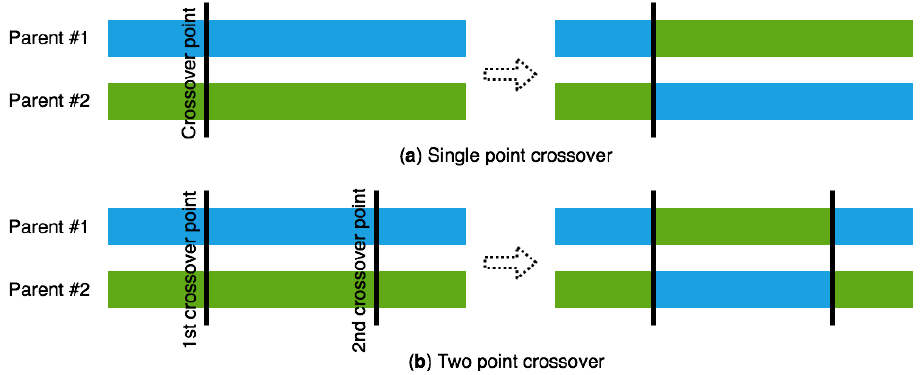
Figure 4. Genetic operator crossover between alleles. ( a ) Single point crossover in which one crossover point is selected, binary string from beginning of chromosome to the crossover point is copied from one parent, the rest is copied from the second parent. ( b ) Two-point crossover in which two crossover point are selected, binary string from beginning of chromosome to the first crossover point is copied from one parent, the part from the first to the second crossover point is copied from the second parent and the rest is copied from the first